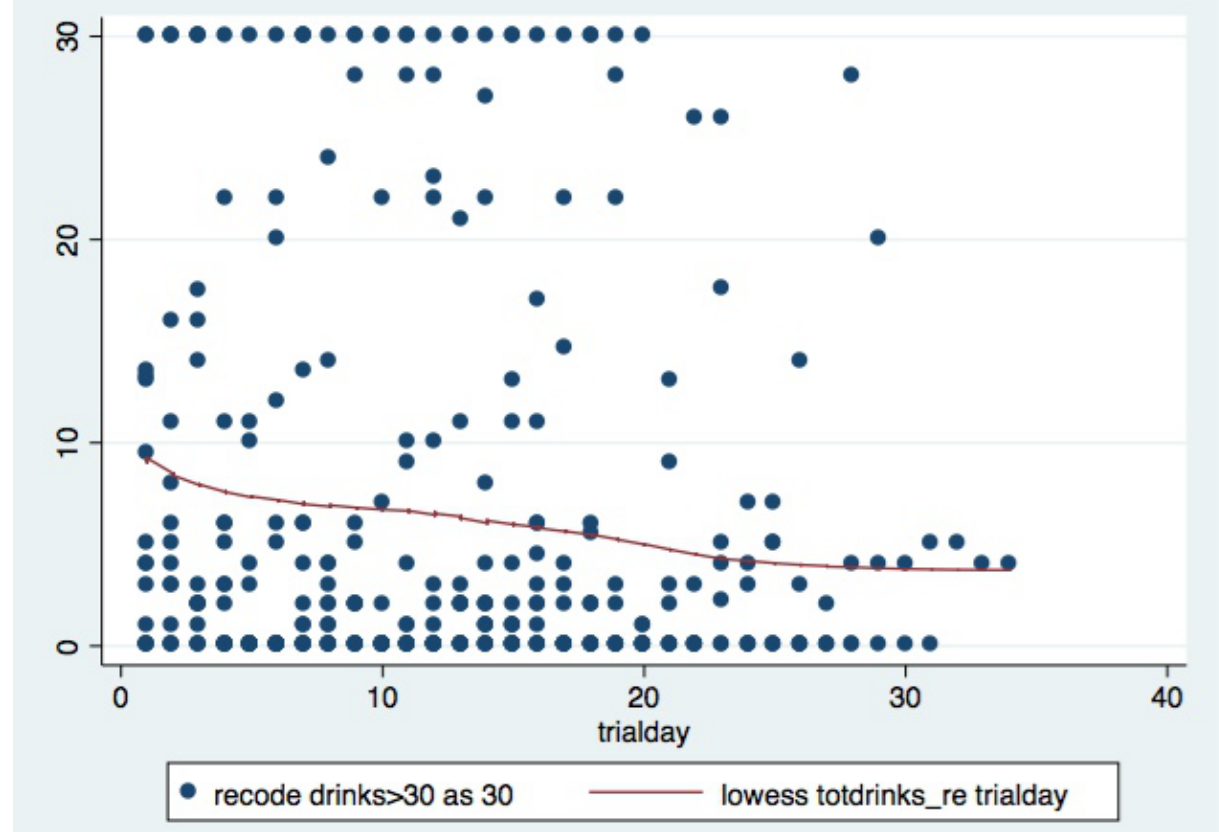
Figure 2. Trend in reporting number of drinks in daily